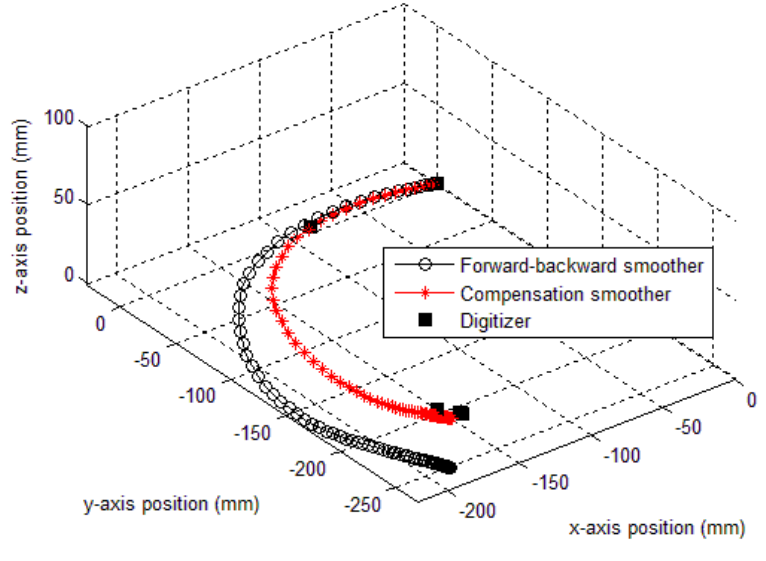
Figure 15. Trajectories of a curve movement experiment (method 1).